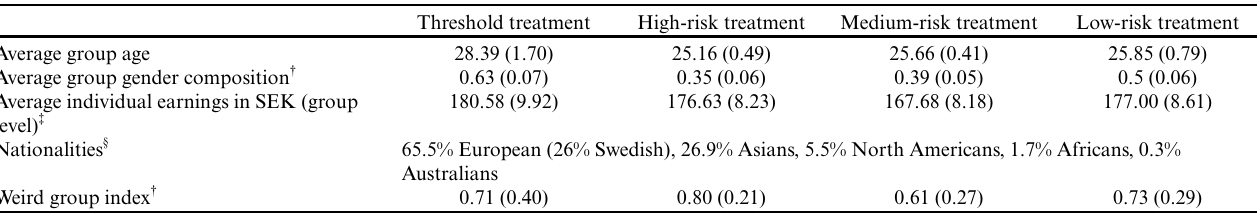
Table 2 . Subject pool characteristics.